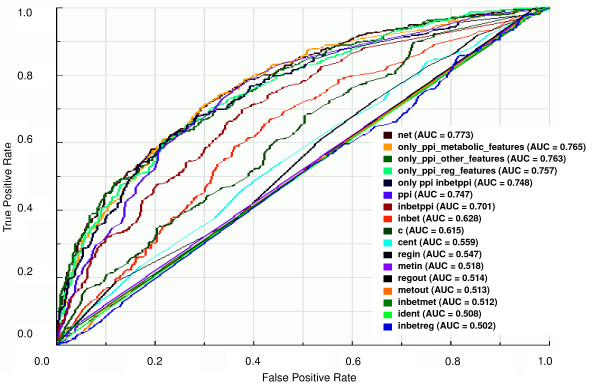
ROC curves and AUC values for the classifiers trained on balanced datasets with individual or grouped network topological features. ROC curves and AUC values of classifiers trained on balanced dataset 9 (see Figure 1) with one or groups of network topological features as learning attributes as follows: "net": all network topological features as learning attributes; "ppi", "inbetppi", "inbet", "c", "cent", "regin", "metin", "regout". "metout", "inbetmet", "ident" and "inbetreg": datasets with only one of the following network topological features as learning attribute: number of protein physical interactions (ppi), betweenness centrality for the protein physical interactions (inbetppi), betweenness centrality for all types of interactions (inbet), clustering coefficient (c), closeness centrality (cent, number of regulating transcription factor (regin), number of reactants participating in a metabolic reaction catalyzed by the enzyme encoded by the gene (metin), number of genes regulated by the transcription factor encoded by the gene (regout), number of products generated in a metabolic reaction catalyzed by the enzyme encoded by the gene (metout), betweenness centrality for the metabolic interactions (inbetmet), number of genes with identical topological features (ident) and betweenness centrality for the transcriptional regulation interactions (inbetreg). "only _ppi_metabolic_features" and "only_ppi_reg_features": datasets containing protein physical interactions-related features (ppi and inbetppi) and, respectively, metabolic (met, metin, metout and inbetmet) and transcriptional regulatory interactions-related features (reg, regin, regout and inbetreg). "only_ppi_other_features": dataset containing protein physical interactions-related features (ppi and inbetppi) and c, ident, cent and inbet. "only_ppi_inbetppi": dataset containing only the indicated network topological features as learning attributes. For more details on network topological features, see Additional file 1.